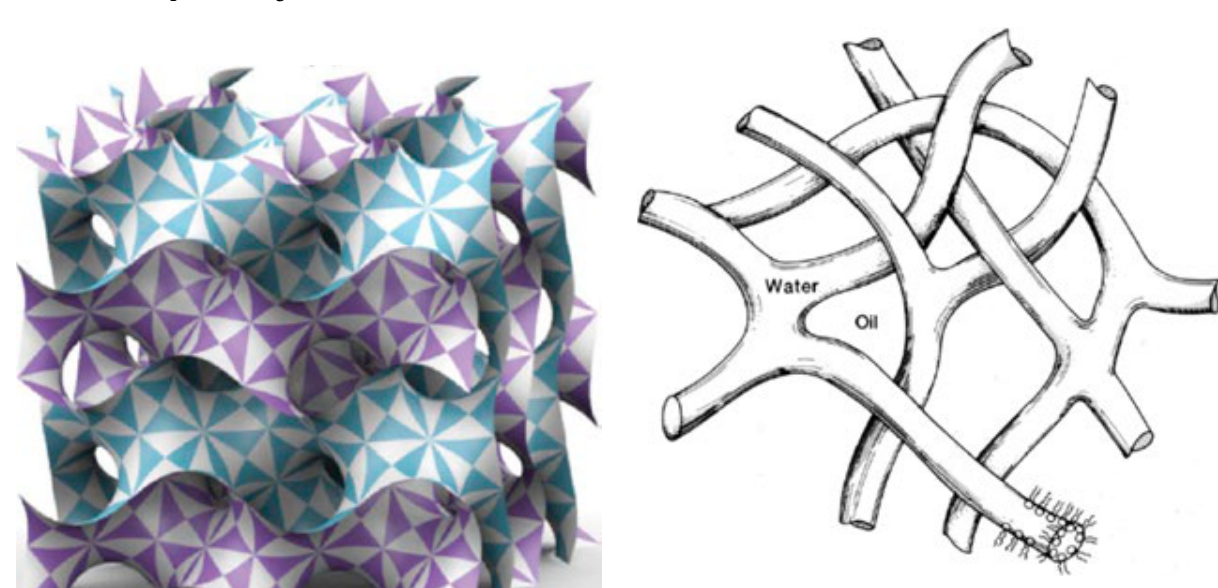
Figure 2. The bicontinuous structure inferred by a conductivity meter 30 years before the cryo-SEM micrographs. The conductivity meter is cheaper than an electron microscope. Such structures were often interpreted as spheres or cylinders from techniques like neu- tron scattering. Reprinted with permission from Ref. 17. Copyright 1986 American Chemical